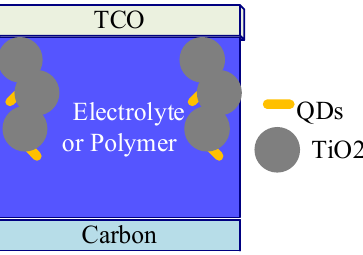
Figure 14. The structure of quantum dot sensitized solar cells, ultrathin film of colloidal QDs is sandwiched between two contacts for the extraction of photogenerated electrons and holes [69].